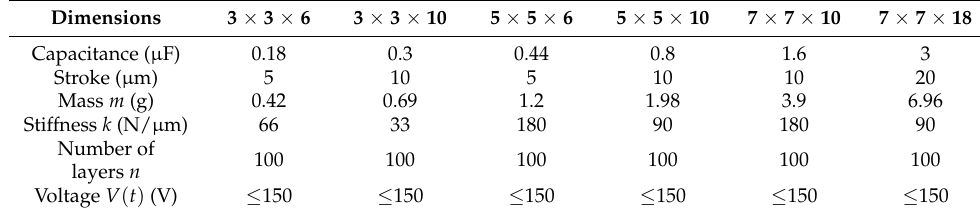
Table 2. Detailed parameters of various types of piezoelectric actuators used in the experiment.